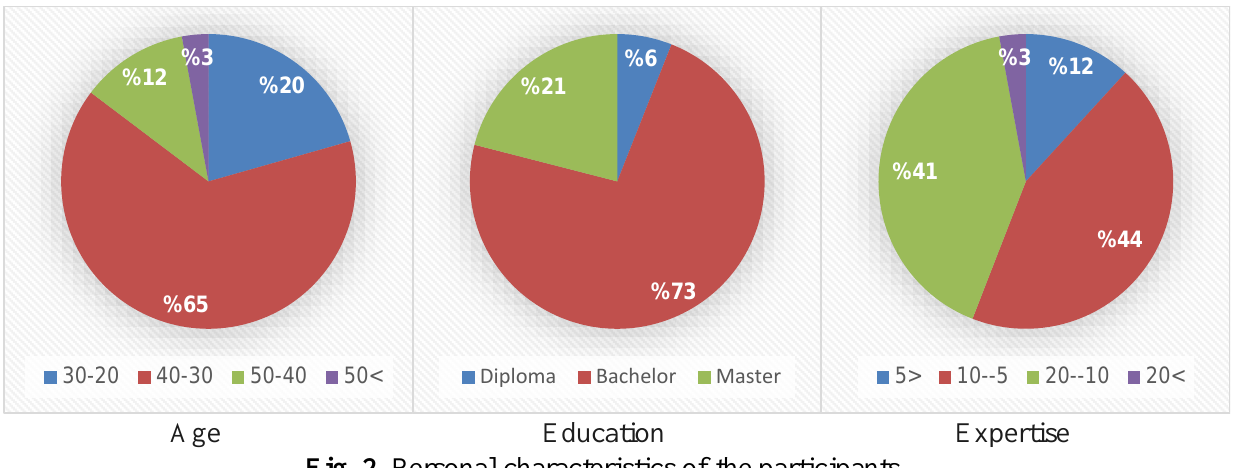
Fig. 2. Personal characteristics of the